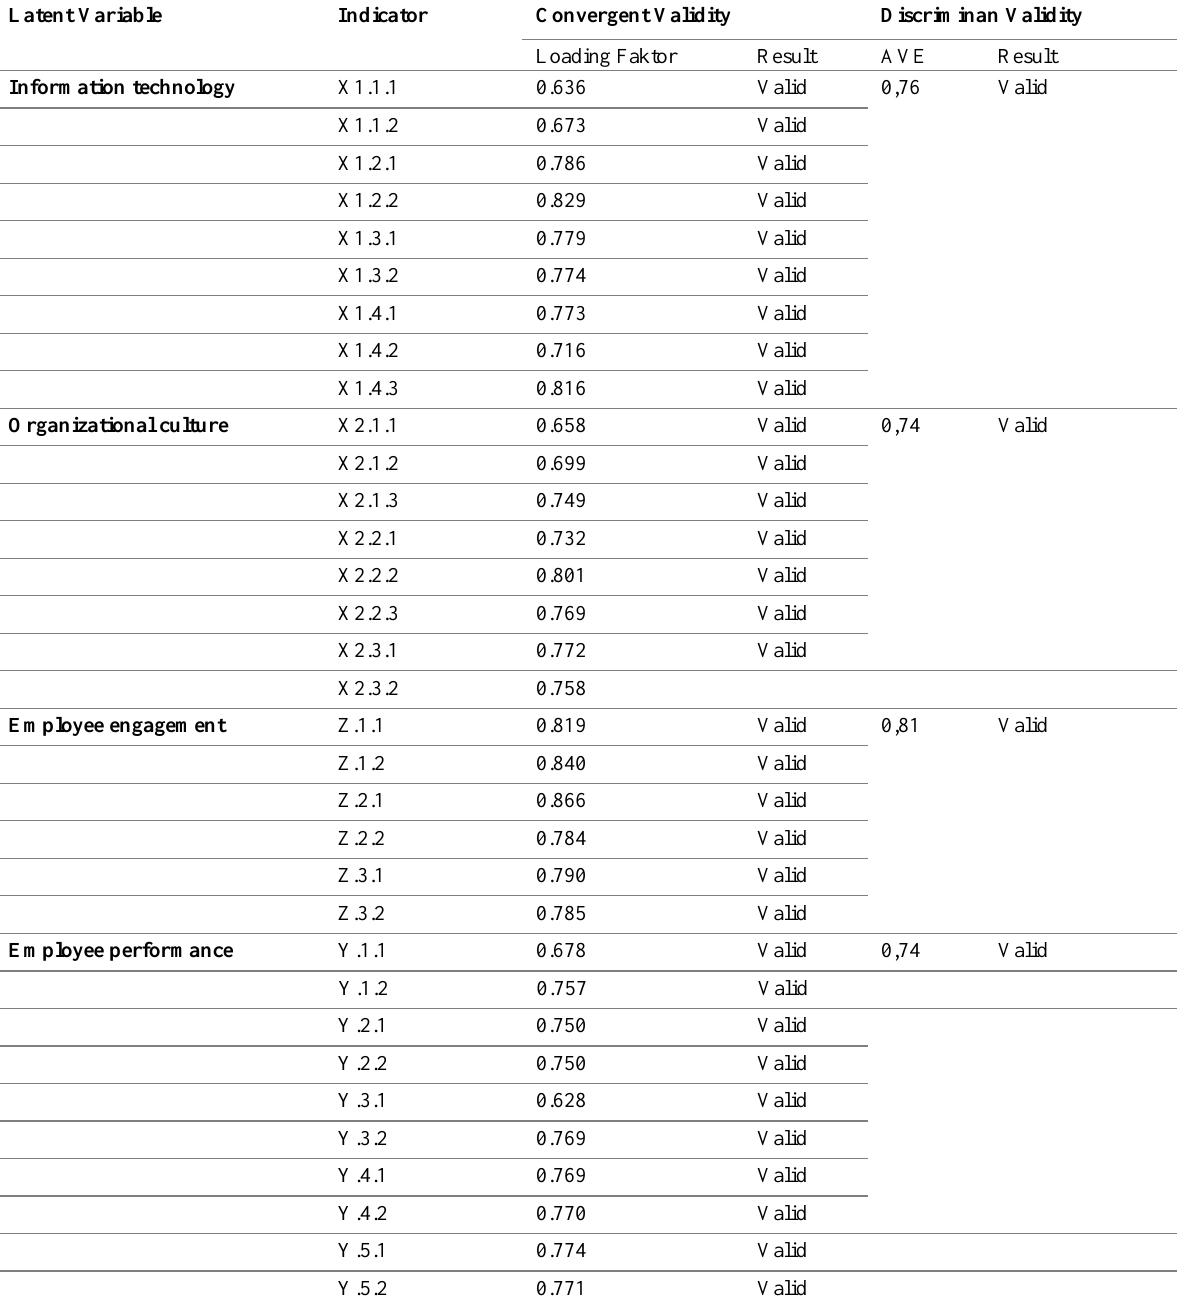
Table 3 : Validity